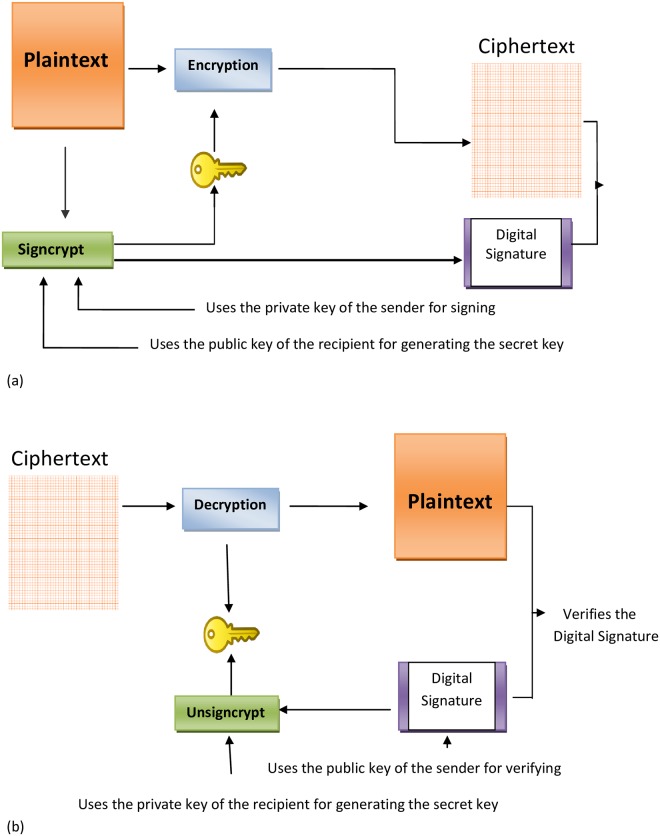
Signcryption model.